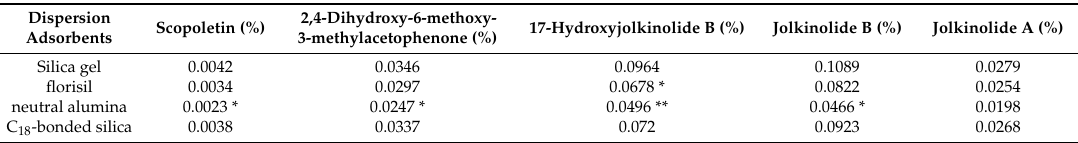
Table 1. Extraction yields (%) obtained using different dispersion adsorbents (silica gel, florisil, neutral alumina, and C 18 -bonded